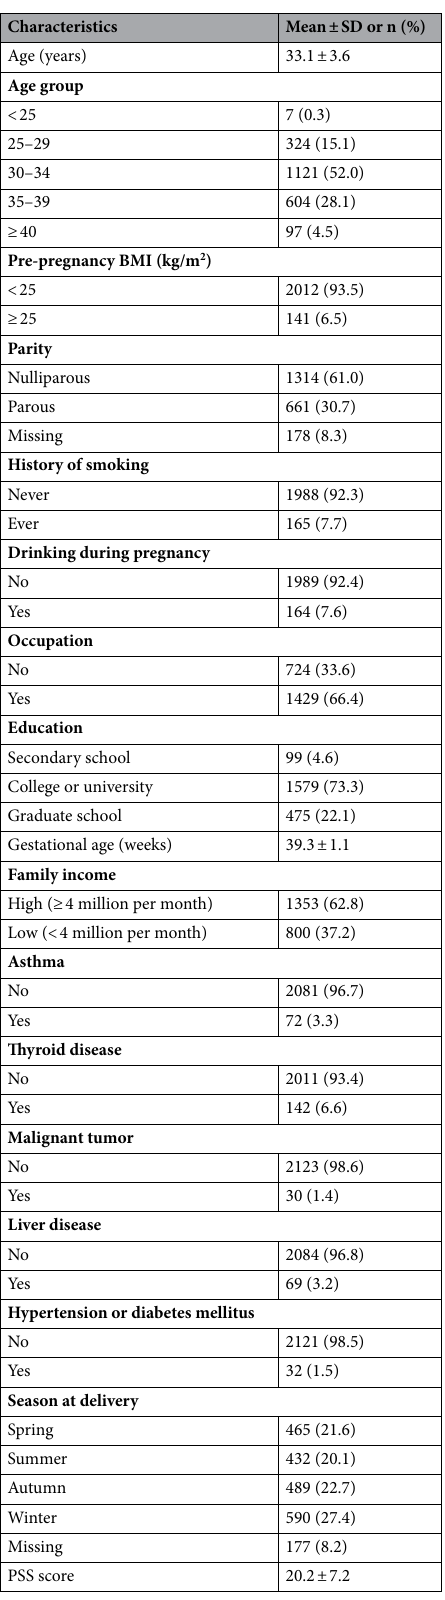
Table 1. Characteristics of participants. BMI body mass index, PSS perceived stress scale, SD standard deviation. n =